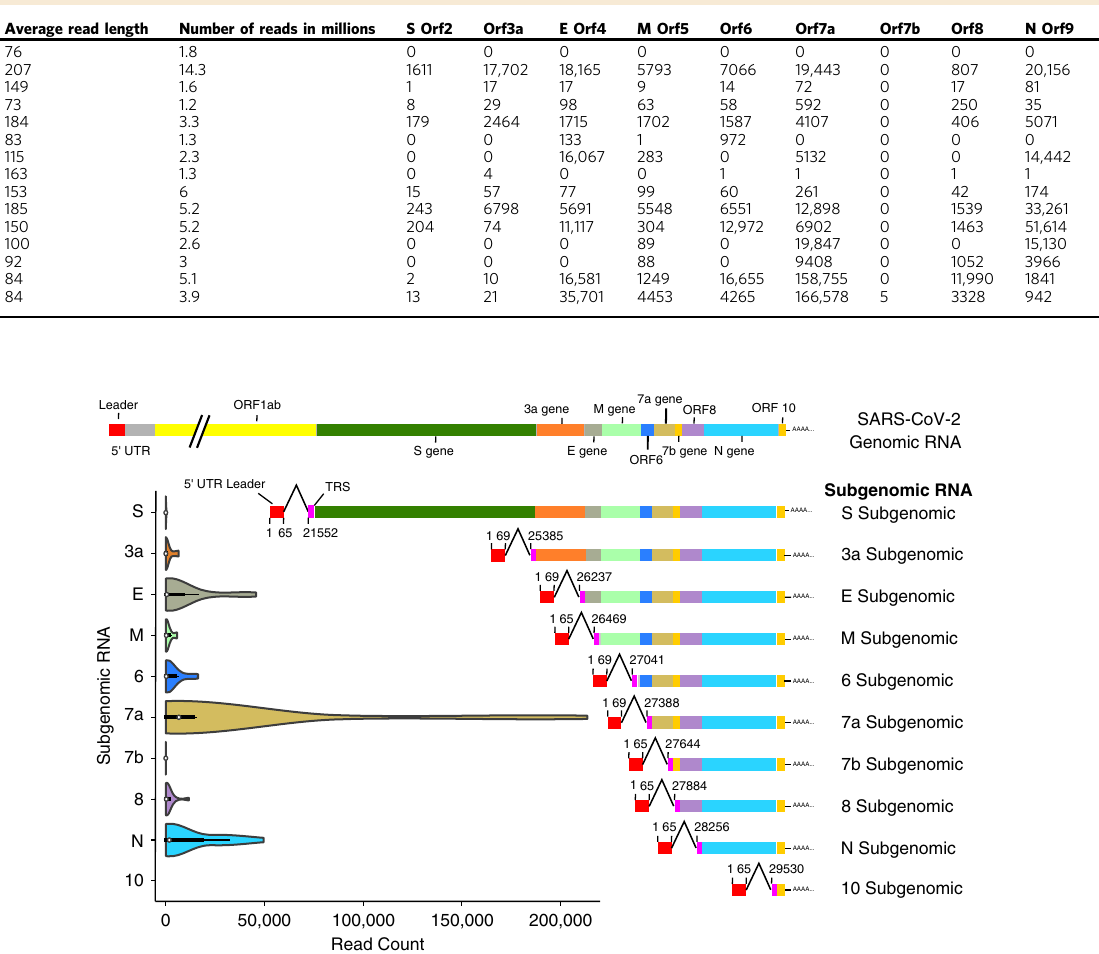
Fig. 1 SARS-CoV-2 genomic and subgenomic RNA structure showing genes and open reading frames (ORF) together with violin plots showing the number of reads per total of 5 million reads in the diagnostic samples mapped to the leader-containing subgenomic RNAs in the fasta fi le used for mapping. The median read count is indicated by the white dot, the interquartile range (IQR) by the thick bar, and the furthest values within 1.5*IQR indicated by the thin black line ( n = 14 data points from 12 biological samples from eight individuals run once). The structure of the SARS-CoV-2 genomic RNA is shown at the top and each subgenomic RNA is illustrated next to the respective violin plot. The nucleotide positions for the leader-TRS (transcription-regulatory sequences) joining locations are indicated alongside each subgenomic RNA (numbering based on reference Wuhan-Hu-1 NC_045512.2/MN908947.3 [https://www.ncbi.nlm.nih.gov/nuccore/NC_045512.2/ and https://www.ncbi.nlm.nih.gov/nuccore/MN908947.3]). In the current study no reads mapped to the tentative Orf10 leader-containing subgenomic